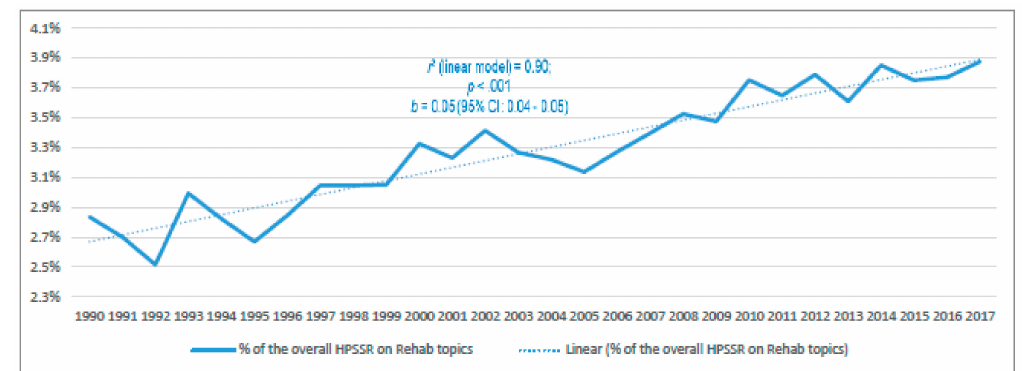
Figure 2. The yearly percentage of the Health Policy, Systems and Service Research (HPSSR) that is focused on Rehab (i.e., rehabilitation) topics from 1990 to 2017, and the regression model (linear) that had the best fit with the data. The p value and 95% Confidence Interval (CI) refer to the linear regression